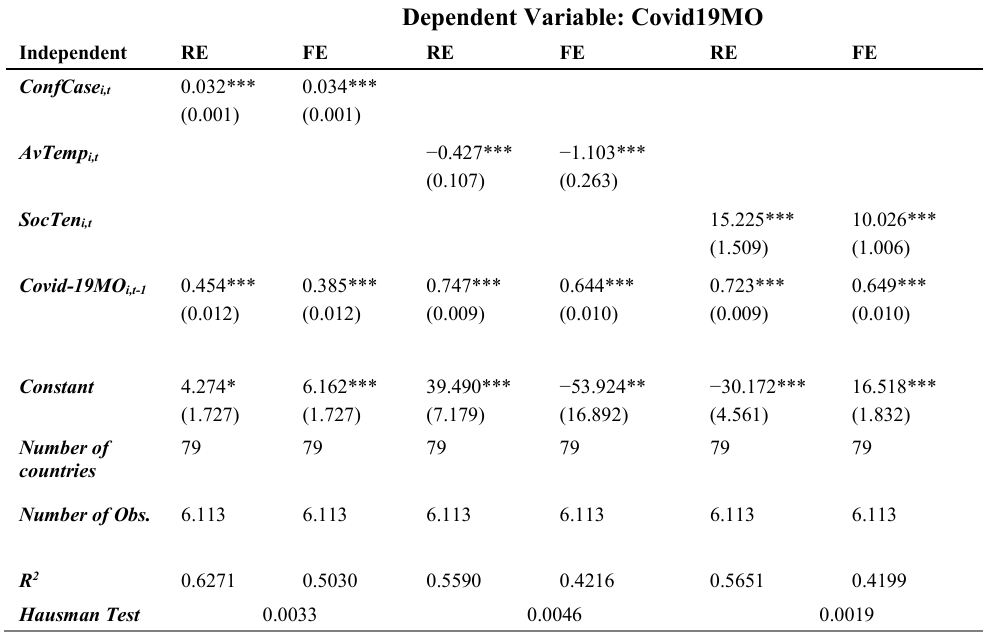
Table 1. Global Panel Fixed and Random Effect Results Dependent Variable: